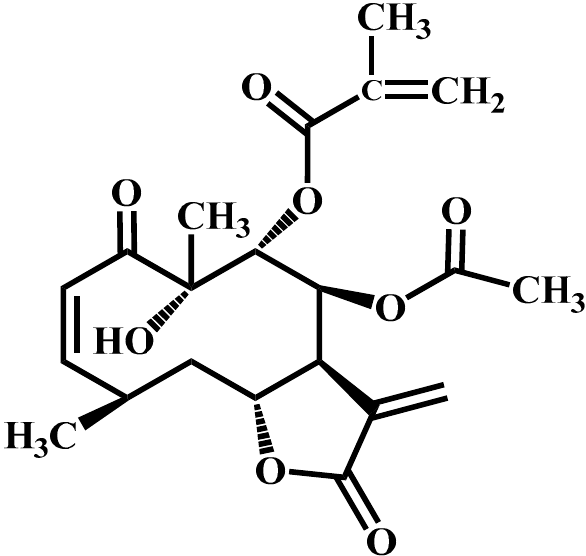
Figure 1. The structure of calein D.